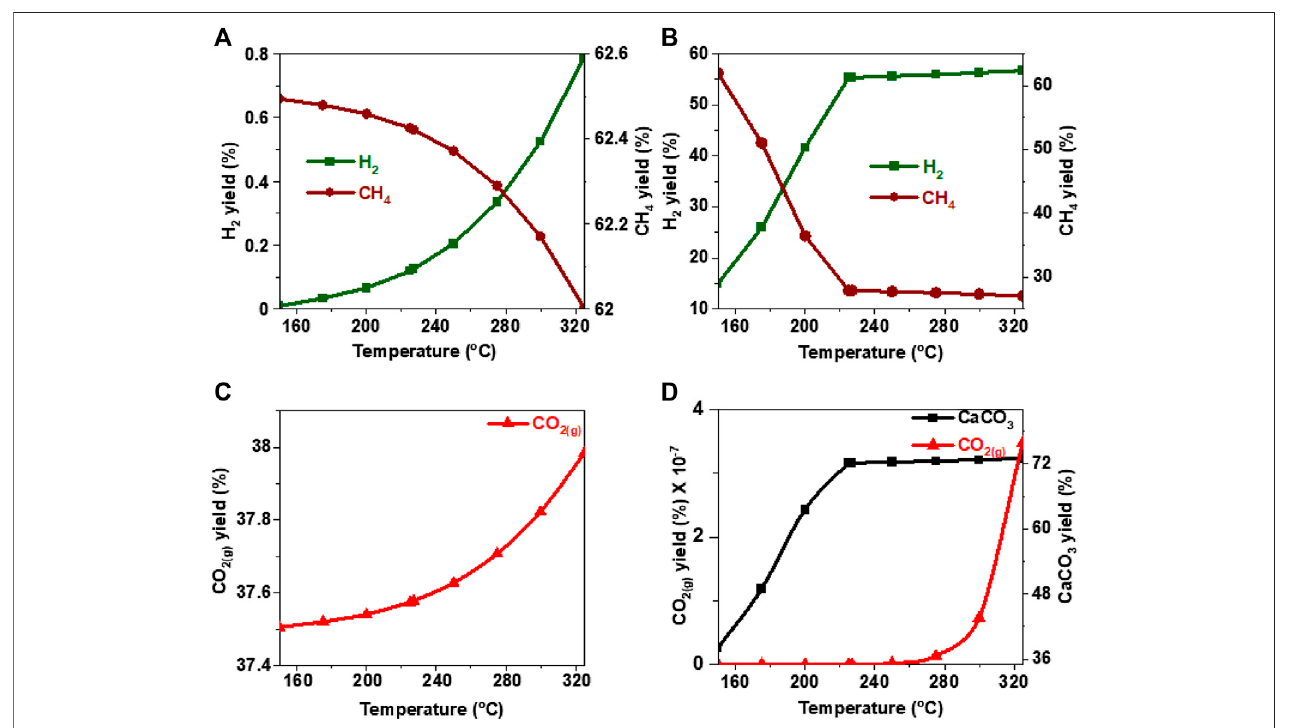
FIGURE 12 | Effect of temperature on the product yield from ethylene glycol (A , C) in the absence and (B) in the presence of calcium oxide. The yield of CO 2 post capture to produce calcium carbonate is represented in 10 (D) . These calculations are performed with temperatures of 227 ° C and pressures of 50 bar.